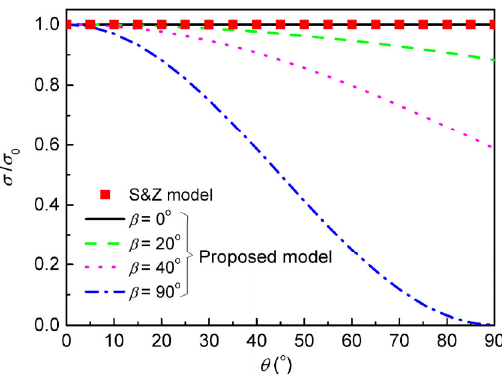
Fig. 4 Normal contact stress as a function of the included angle  with a zero-recovery